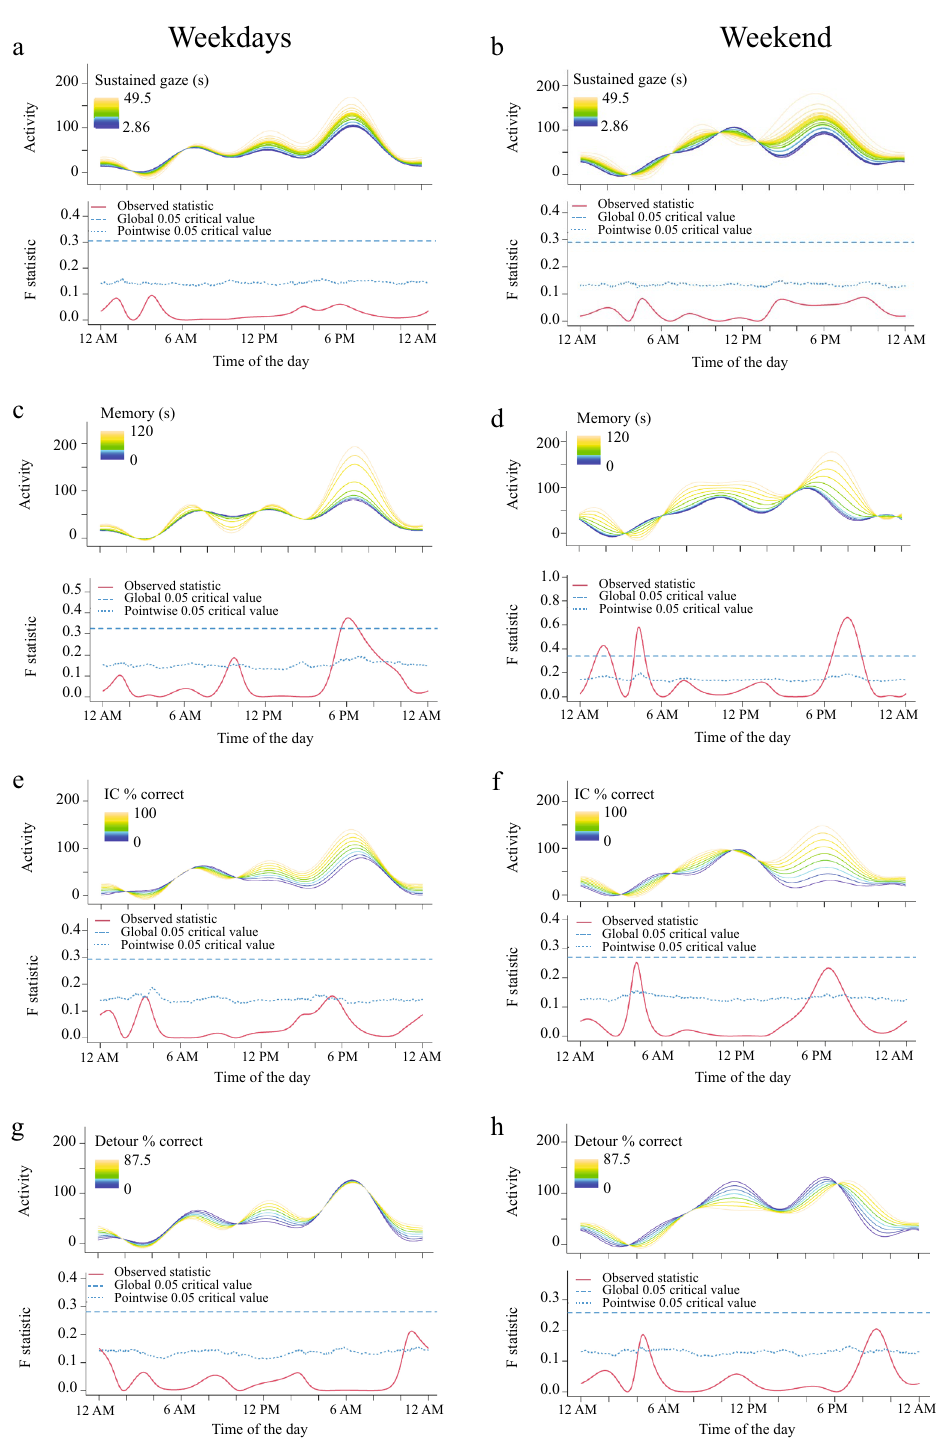
Figure 3. Relationship between performance on cognitive testing and activity levels in senior dogs on weekdays ( a,c,e,g ) and weekends ( b,d,f,h ). The upper graph illustrates activity over time for different levels of the variables analyzed and the lower graph indicates the level of significance of the differences. When the observed statistic (red line) is above the test of significance set at 0.05 (blue lines) it indicates significant differences between different levels of the variable. The dashed and the dotted lines indicate global and point-wise test of significance respectively. No relationship was observed with performance at sustained gaze ( a,b ). Dogs with higher scores in memory tasks were more active in the evening during weekdays ( c ) and weekend (d). On weekends they were also more active between 12 and 2.45 AM and less active between 3.45 and 5.30 AM. On weekdays, dogs with better performance also showed a reduction in activity levels between 9 and 10.15, but this did not surpass the global significance. Performance on the cylinder tasks, considered tests of executive function, was less clearly associated with activity levels ( e,g ). Differences were most notable at the weekend when dogs are more active, but non achieved global